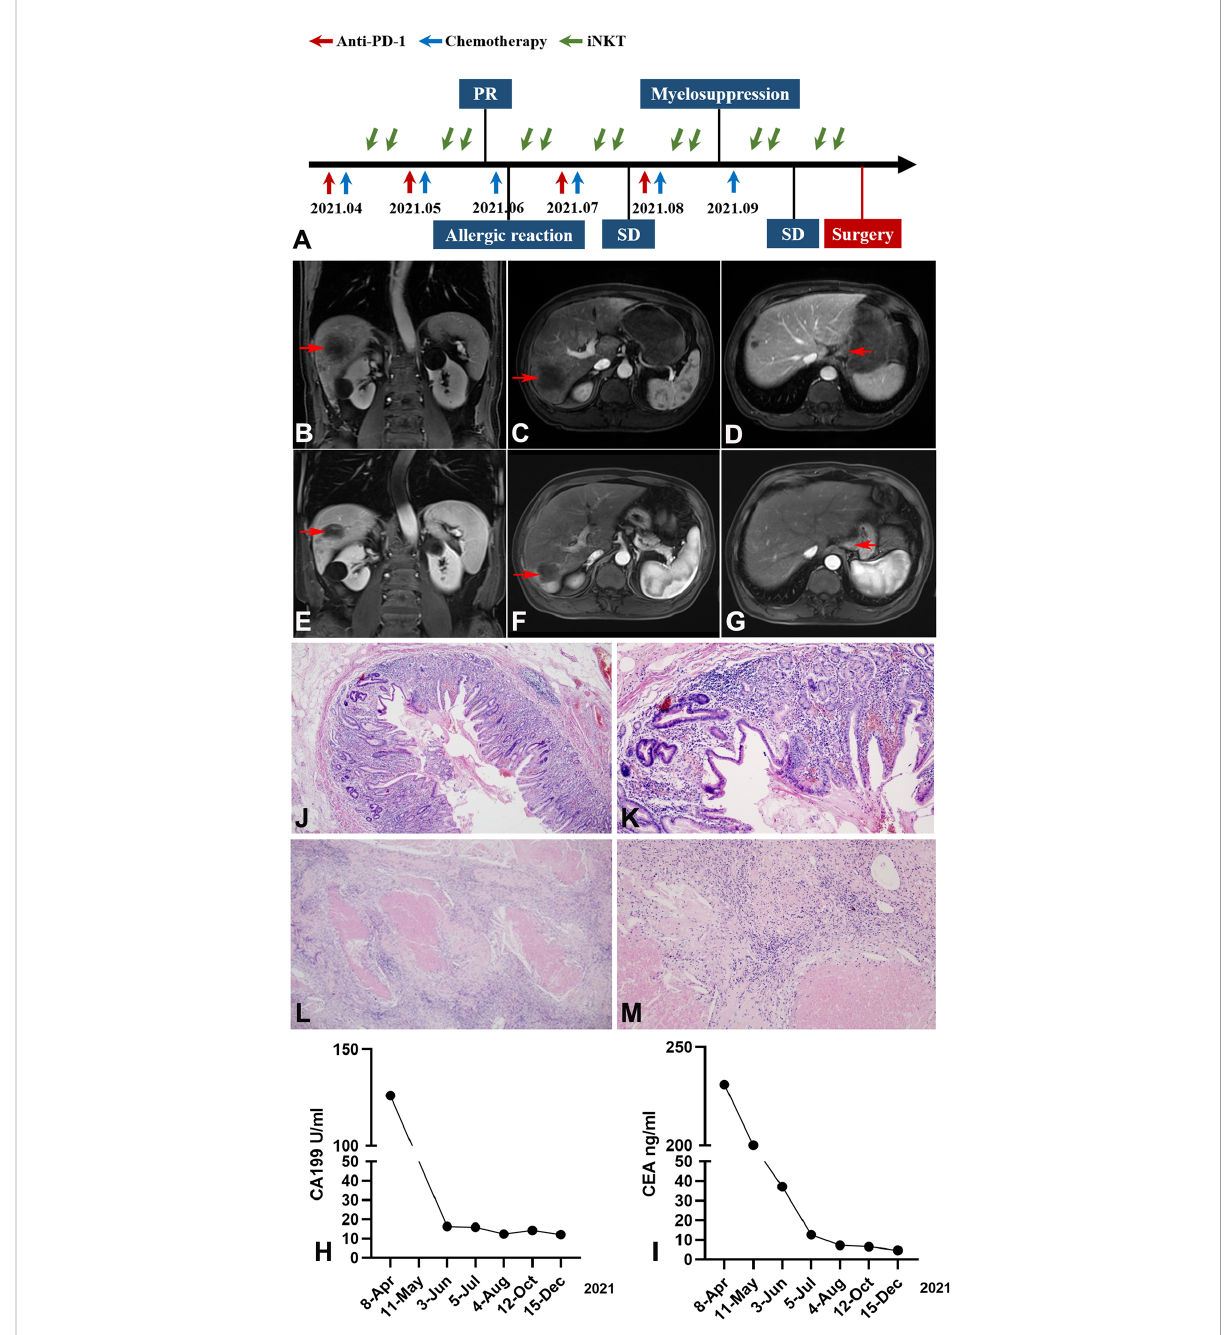
FIGURE 2 Imaging, pathological and clinical parameters of the patient following study design (tumor marked with red arrow). (A) The patient received a multimodal therapy comprised of SOX chemotherapy, anti-PD-1 therapy, and iNKT cell immunotherapy followed by surgical resection. The SOX regimen was administered every 21 days; Anti-PD-1 mAb was administered intravenously once every 21 days; iNKT cells were infused twice monthly. (B – D) Abdominal MRI revealed a decrease of the metastatic tumor in the liver and the lesion occupying the cardia region (after 2 cycles of treatment). (B) Coronal imaging of the lesion on liver, (C) Sagittal imaging of the lesion on liver, (D) Sagittal imaging of the lesion on gastric cardia. (E – G) Abdominal MRI revealed a further decrease of the largest metastatic tumor in the liver (after 6 cycles of treatment). (E) Coronal imaging of the lesion on liver, (F) Sagittal imaging of the lesion on liver, (G) Sagittal imaging of the lesion on gastric cardia. (H, I) The downward trend of CEA and CA-199 during treatment (CEA normal range, 0.0 – 5.0 ng/mL; CA199 normal range, 0.00 – 37.00 U/mL). (J – M) Pathological examination of gastric and liver biopsy specimen con fi rmed pCR after surgery. Gastric specimen ( J , magni fi cation×40, K , magni fi cation×100); Liver specimen ( L , magni fi cation×40, M , magni fi